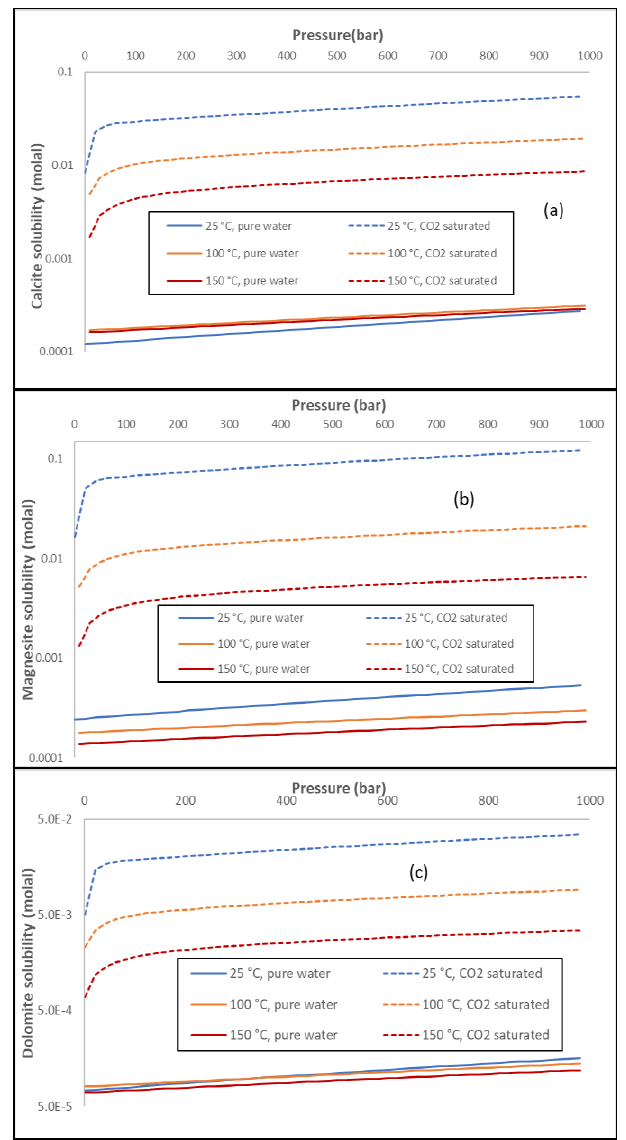
Figure 12. Carbonate mineral solubility in pure water or in CO 2 saturated solutions. ( a ) Calcite solubility. ( b ) Magnesite solubility. ( c ) Dolomite solubility.